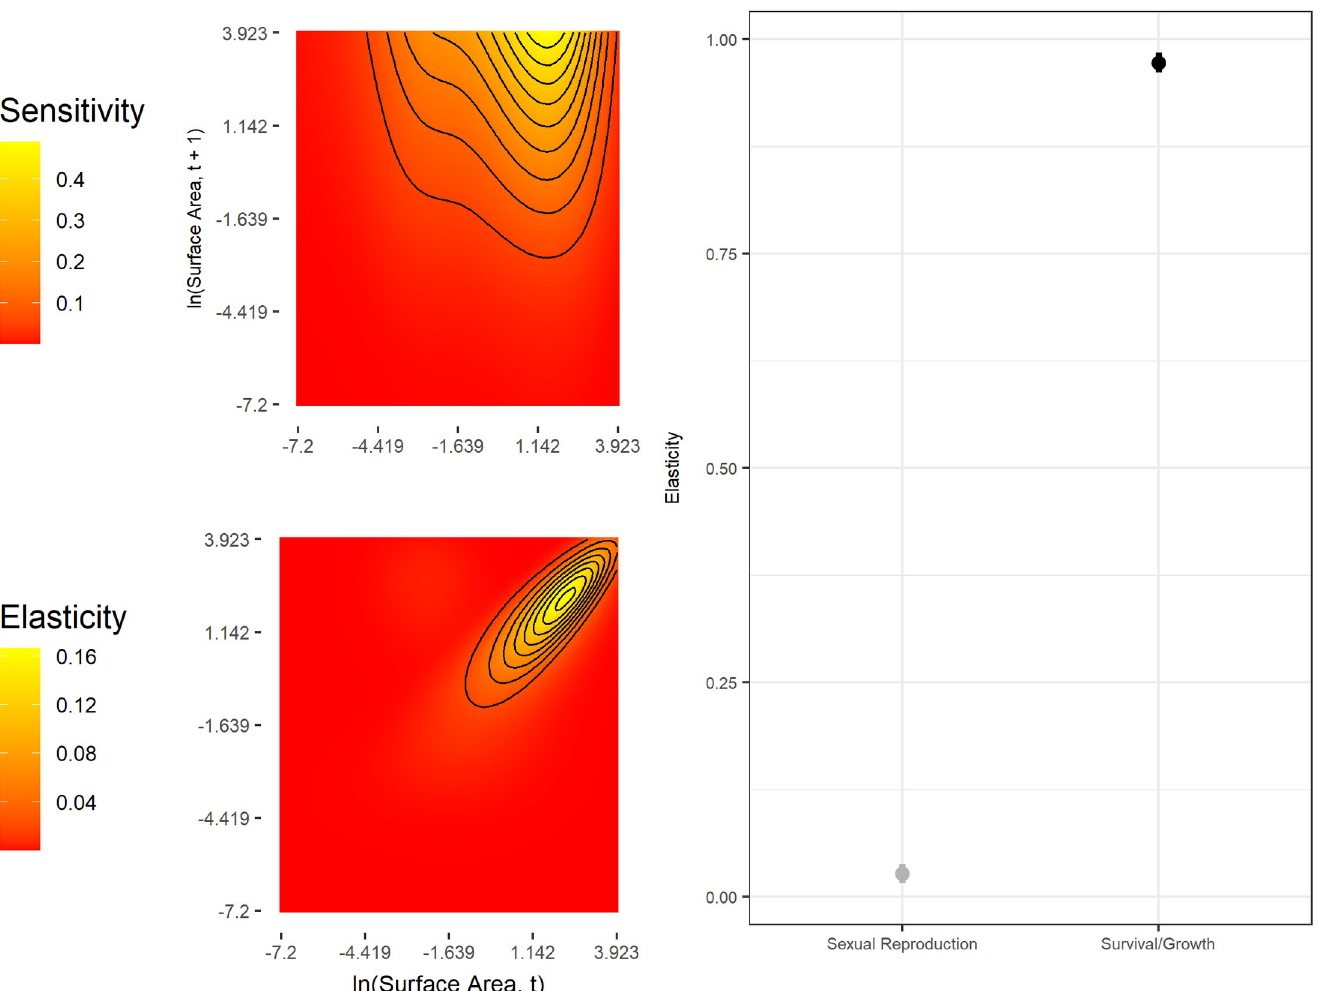
Fig 4. Sensitivity and elasticity functions of λ . Left: Sensitivity and elasticity kernels for the complete model. Right: Elasticities for each sub-kernel, indicating relative contributions of each to the per-capita growth rate. The range line for each point estimate of the sub-kernel level elasticity shows the 95% confidence interval derived from the boot strapping